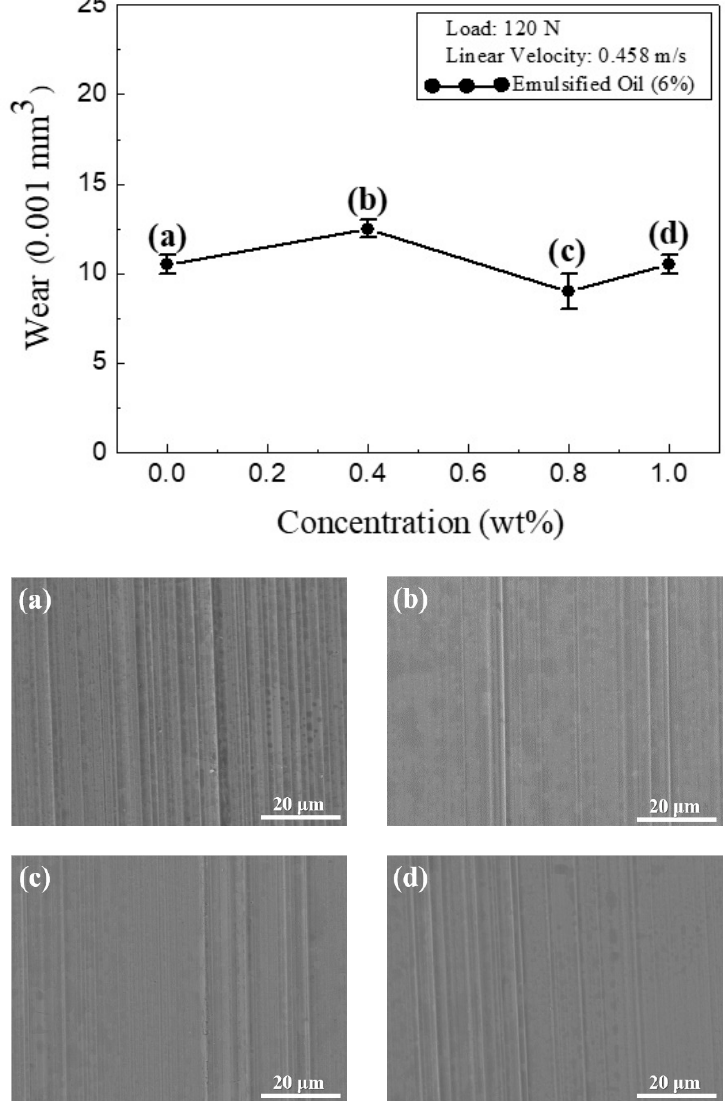
Figure 8. Variation of wear volume with CNC concentrations in O / W emulsions. SEM images show wear surface following sliding with O / W emulsion lubricant with ( a ) 0 wt.%, ( b ) 0.4 wt.%, ( c ) 0.8 wt.%, and ( d ) 1.0 wt.% CNC additions.